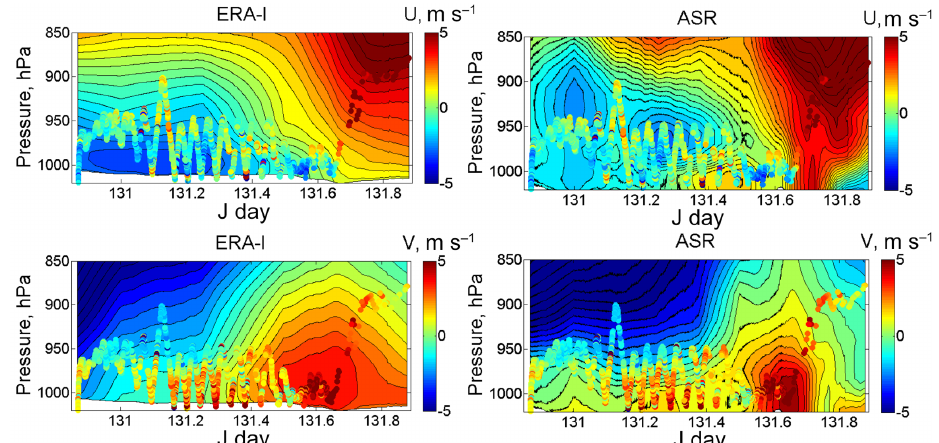
Figure 9. U and V winds observed during the CMET flight 5 soundings (filled circles) compared to 4-D interpolated (latitude, longitude, pressure, time) model data from ERA-I and